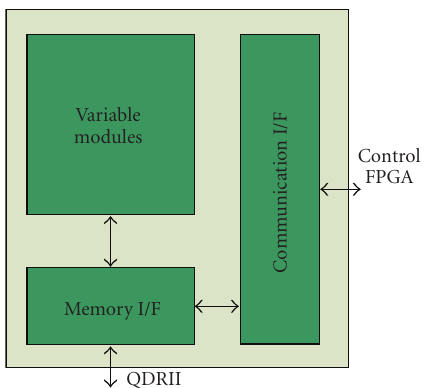
Figure 9: Block diagram of a computing FPGA: generic interfaces for communication with the control FPGA (communication I/F) via Local Bus or Fast Links and access to QDRII memory (memory I/F). The variable algorithmic part is also